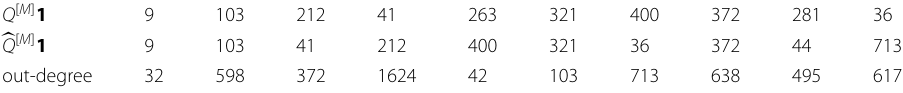
Table 7 FBsoc: Top 10 ranked nodes: exact, approximate and with aggregate out-degree Q [ M ] 1